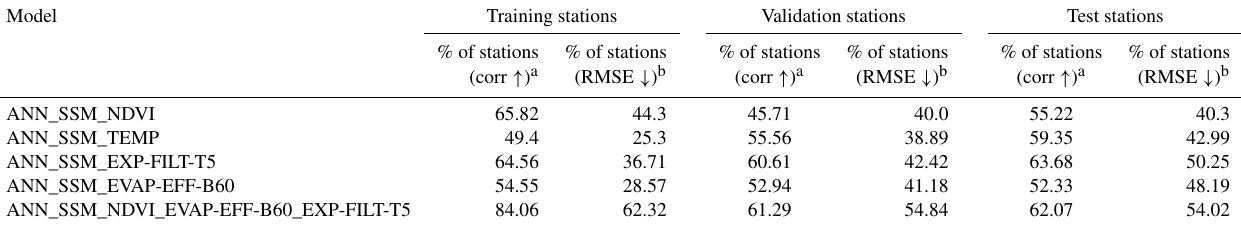
Table 3. Proportion of the stations whose performance enhances using the ANN models enriched with process-related features compared to model ANN_SSM ( a : % of stations at which the correlation improves over the model ANN_SSM level; b : % of stations at which RMSE improves over the model ANN_SSM